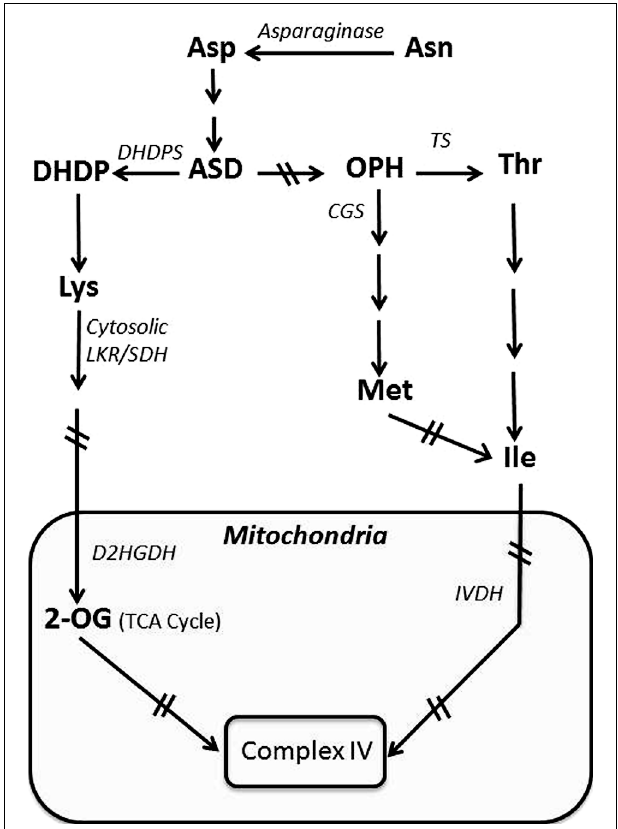
FIGURE 1 | Schematic diagram showing the synthesis of the amino acids of theAsp-family pathway and their catabolism by theTCA cycle. The mitochondrial enzymatic complex is highlighted by a black box. Abbreviations: 2-OG, 2-oxoglutarate; ASD, aspartic semialdehyde dehydrogenase; CGS, cystathionine gamma synthase; D2HGDH, 2-D-hydroxyglutarate dehydrogenase; DHDP, dihydrodipicolinate; DHDPS, dihydrodipicolinate synthase; IVDH, isovaleryl-CoA dehydrogenase; LKR/SDH, lysine ketoglutarate reductase/saccharopine dehydrogenase; OPH, O - phospho_ L _homoserine;TS,Thr synthase. Arrows with two crossed lines represent several enzymatic